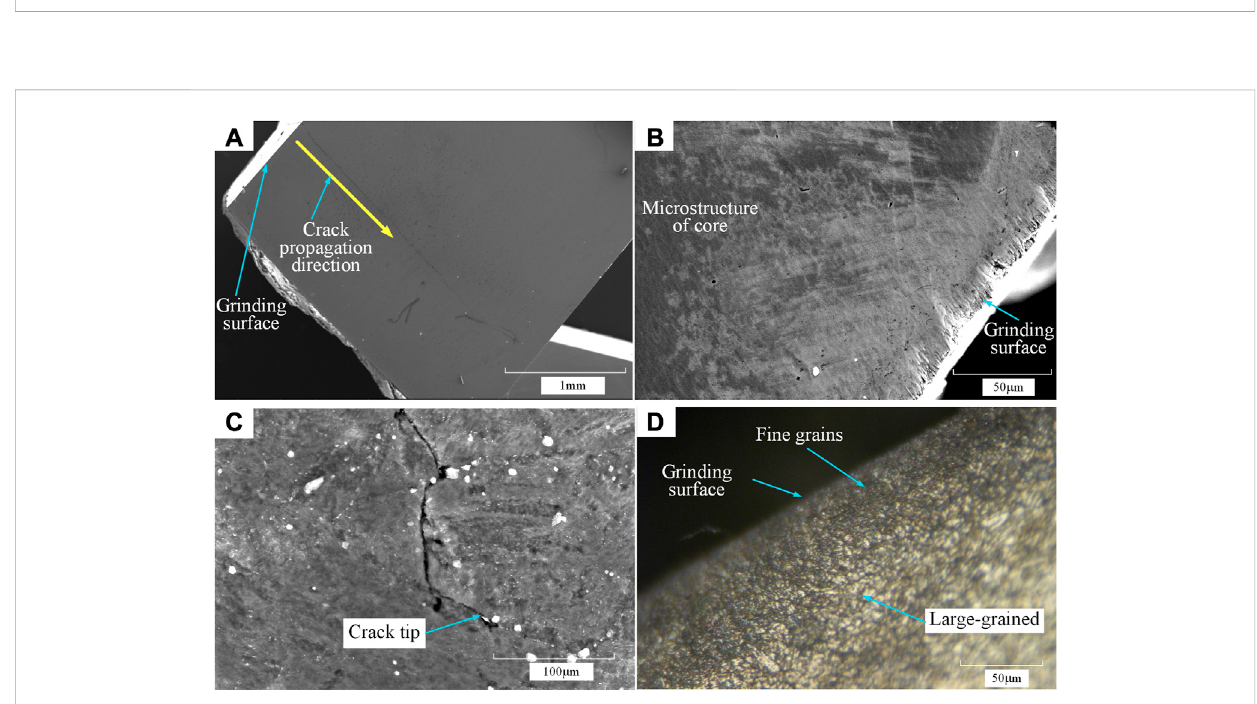
sectional microstructure diagram of the micro-pit is shown in Figure 3D, and it can be seen that the size of the micro-pit is about 50 μ m. In addition, the grain size at the bottom of the micro- pit is larger than that at the surface of the micro-pit.